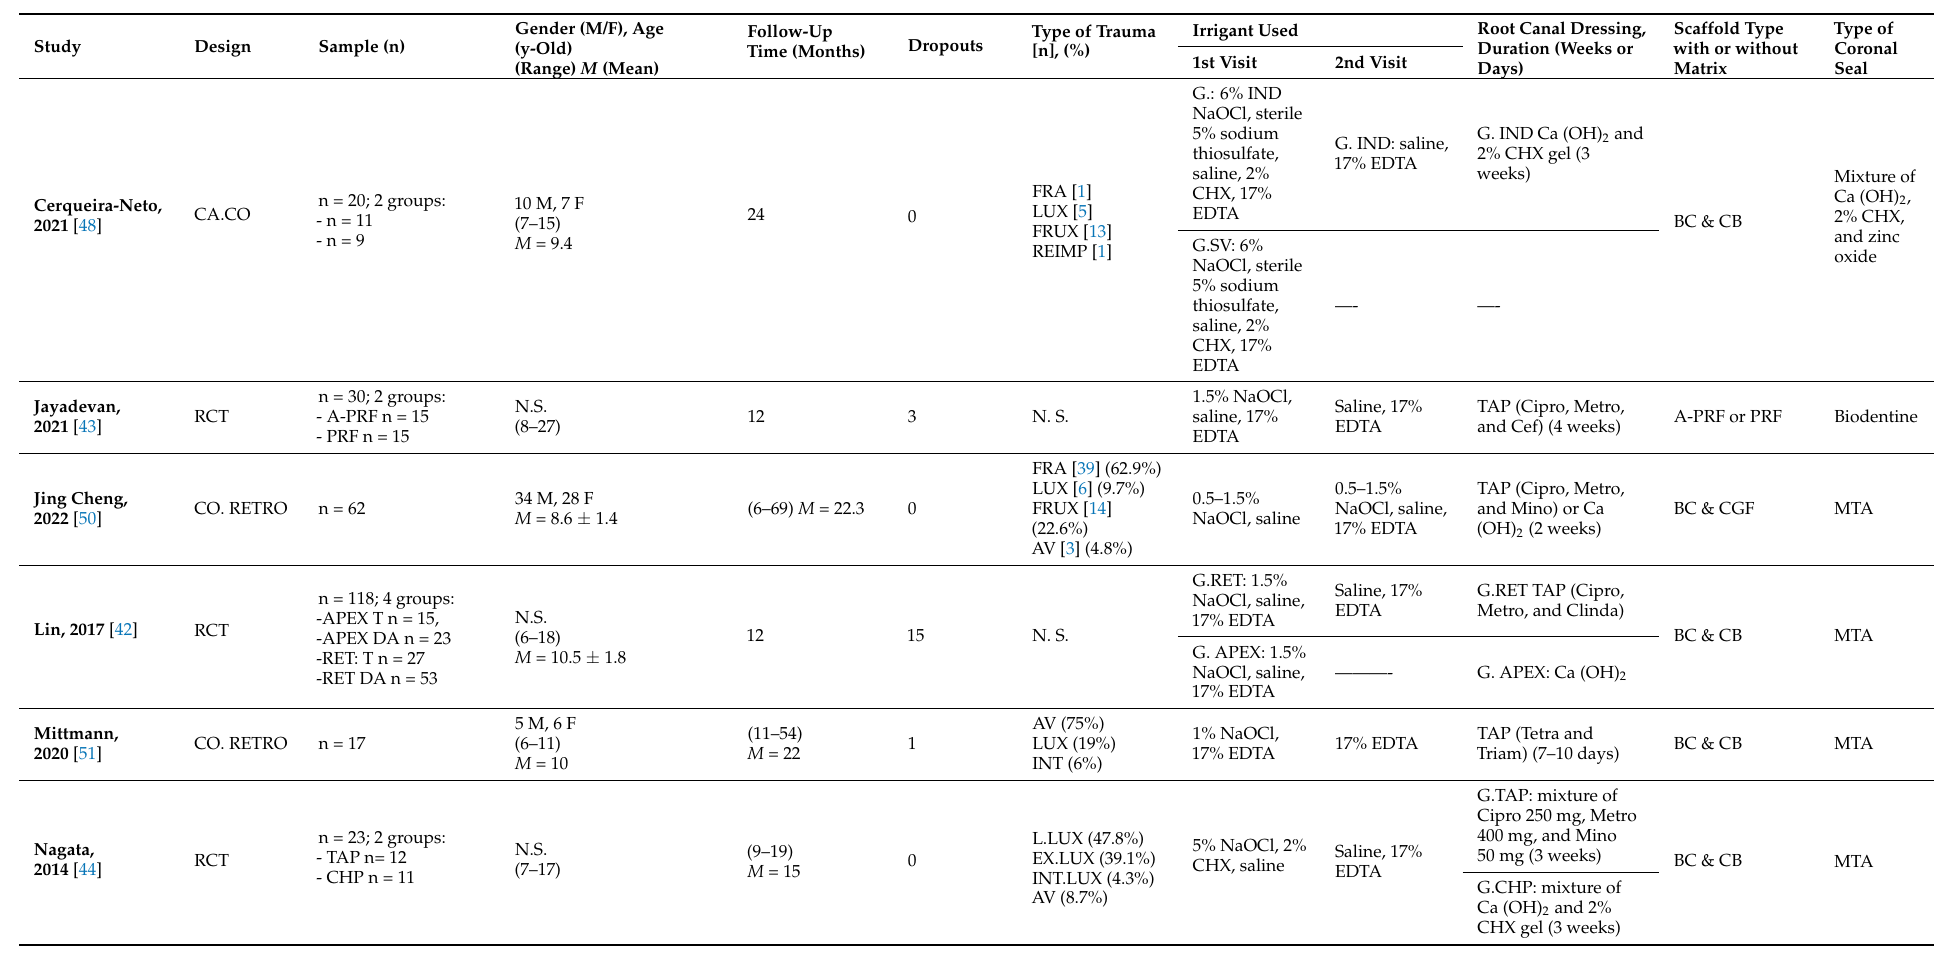
Table 1. Methodological characteristics of the included